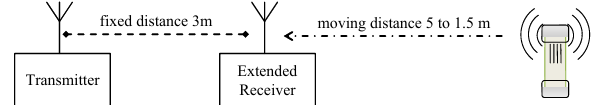
Considering Equation 5 this yields in: